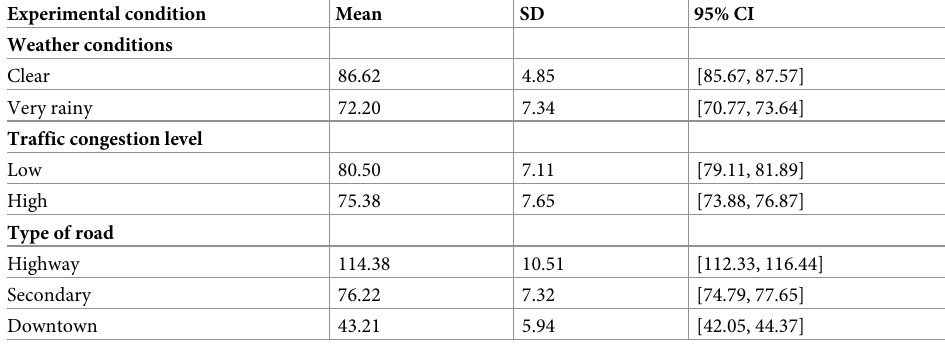
Table 7. Participants’ reported manual driving speed (in km/h) according to type of road × weather conditions. Type of road